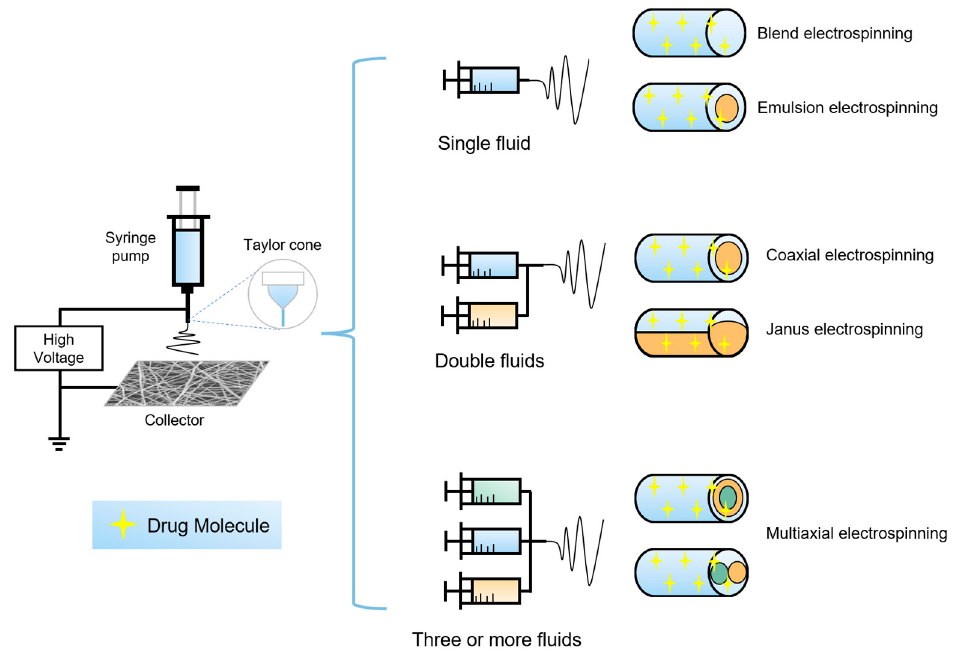
Figure 4. Electrospinning device and classification of electrospinning according to fluid quantity and spinneret structure.